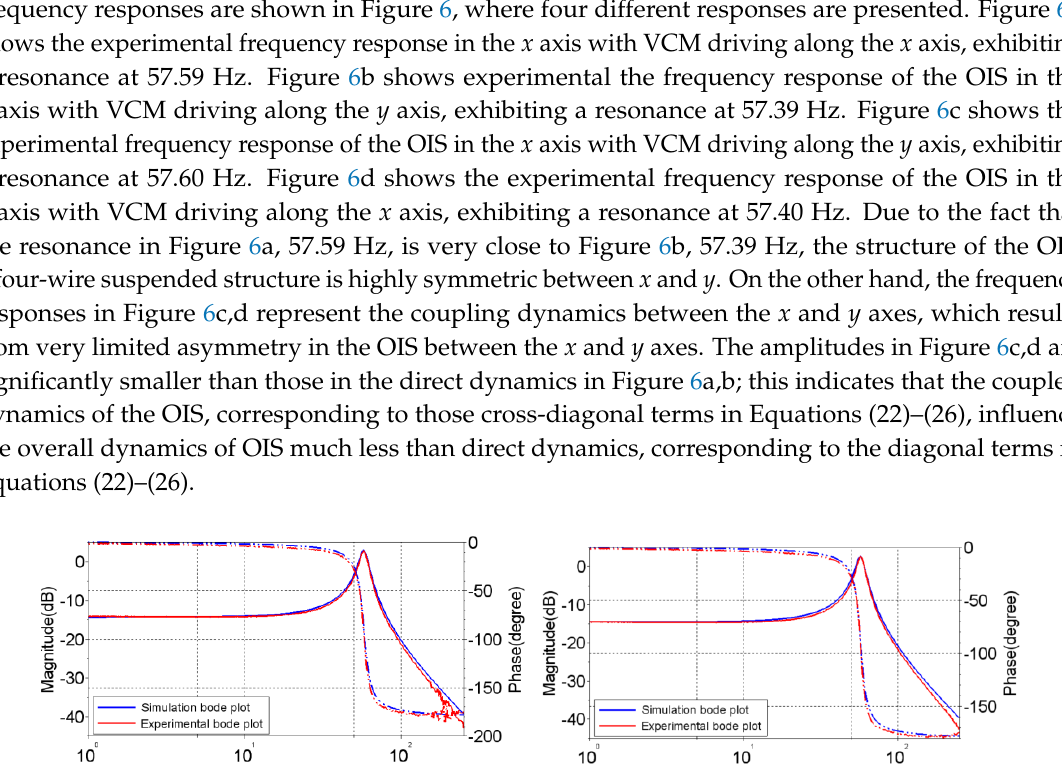
Table 2. Parameters of optical image stabilizer.